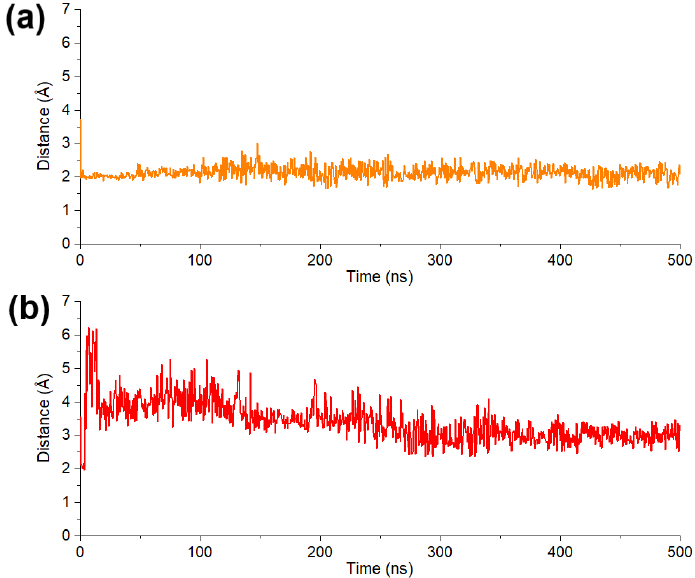
Figure 7. ( a ) Average distance between 4-OH of pyrogallol moiety in DF-47 and two Mg 2+ . ( b ) Dis- tance between 4-OH of pyrogallol moiety in DF-51 and Mg 2+ .